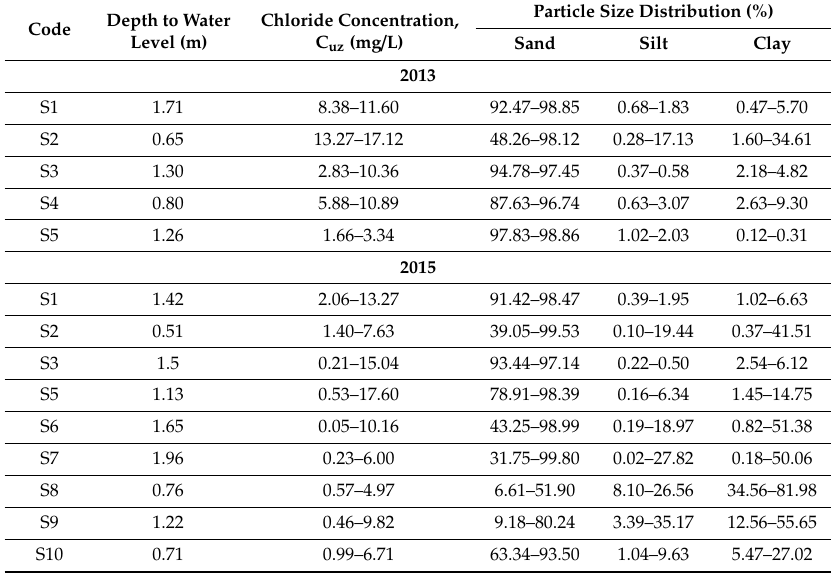
Table 1. Summary of soil samples depth to water level, chloride concentration and percentage of particle